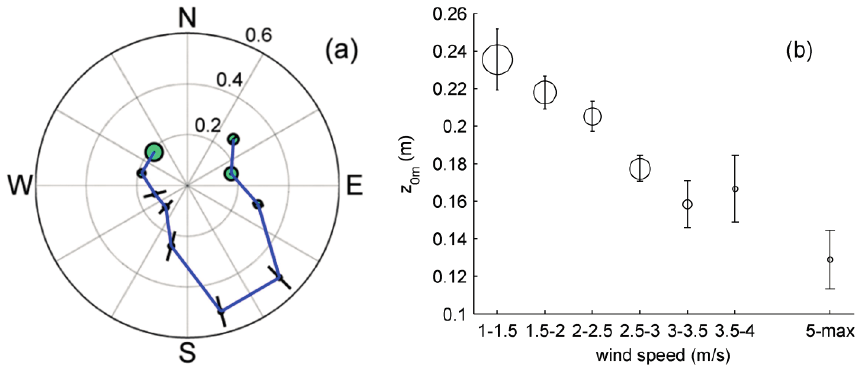
Figure 9. Examples of aerodynamic roughness length changing with atmospheric conditions: ( a ) variation of EC-derived roughness with wind direction for maize site 1, indicating suboptimal fetch conditions in the south; ( b ) EC-derived roughness against wind speed for maize site 1, indicating the effect of crop bending with increased wind on the roughness length. The size of the circles in both (a) and (b) scales by the degrees of freedom in each fitting program, and error bars centered at each data point indicate 95% confidence intervals of the regression